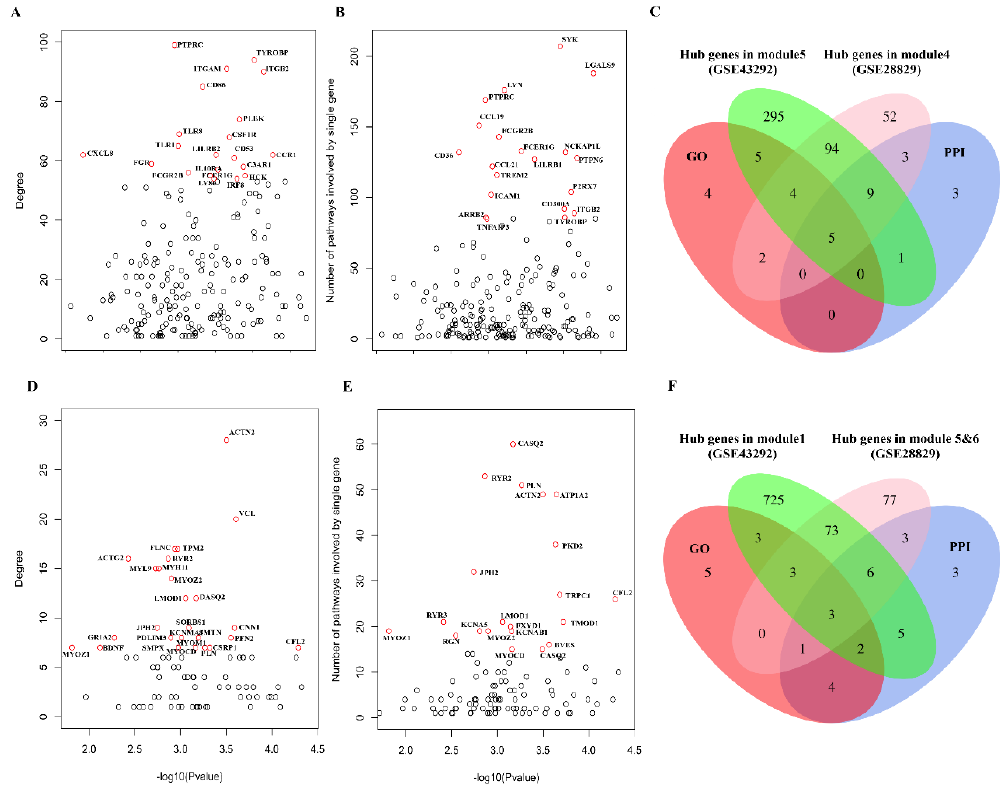
Figure 5. The eight essential genes were identified by integrating the results of PPI, GO, and Gene co-expression module analysis. ( A ) The top 20 genes with the highest degree value of protein-protein network interactions for 259 highly upregulated genes. ( B ) GO analysis demonstrates that the top 20 genes primarily involve immune-related pathways. ( C ) Five genes were identified as key genes for immune responses based on PPI, GO, and Gene co-expression module analysis results. ( D ) The top 20 genes with the highest degree value of protein—protein network interactions for 218 highly downregulated genes. ( E ) The top 20 genes are involved in muscle-related pathways, as shown by GO analysis. ( F ) The results of three genes were identified as key for muscle system-related pathways based on PPI, GO, and Gene co-expression module analysis. Hub genes in modules represent genes exhibiting an absolute correlation coefficient > 0.85 within the eigengene of the modules related to immune or muscle-related pathways based on WGCNA analysis of GSE43292 and GSE28829 datasets. The dot represents different genes. The red dot represents the top 20 genes in the corresponding